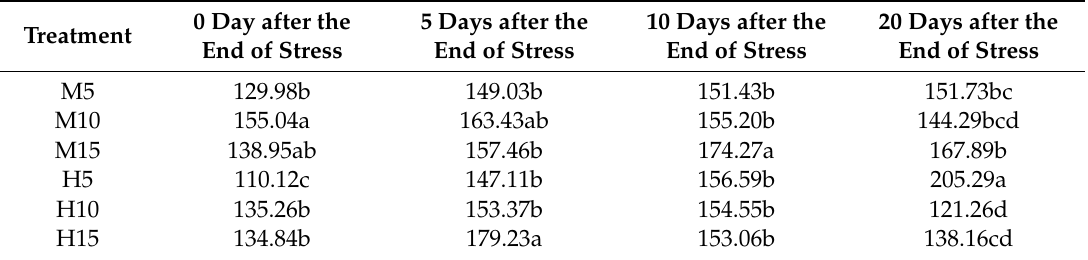
Table 5. Stele diameter after exposure to high temperature and waterlogging at booting stage in rice ( µ